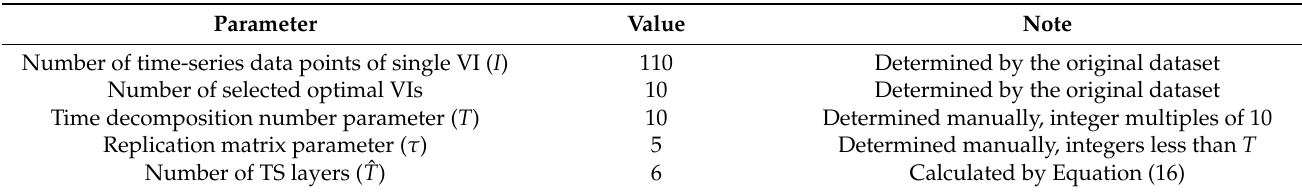
Table 3. Setting of BHT-ARIMA